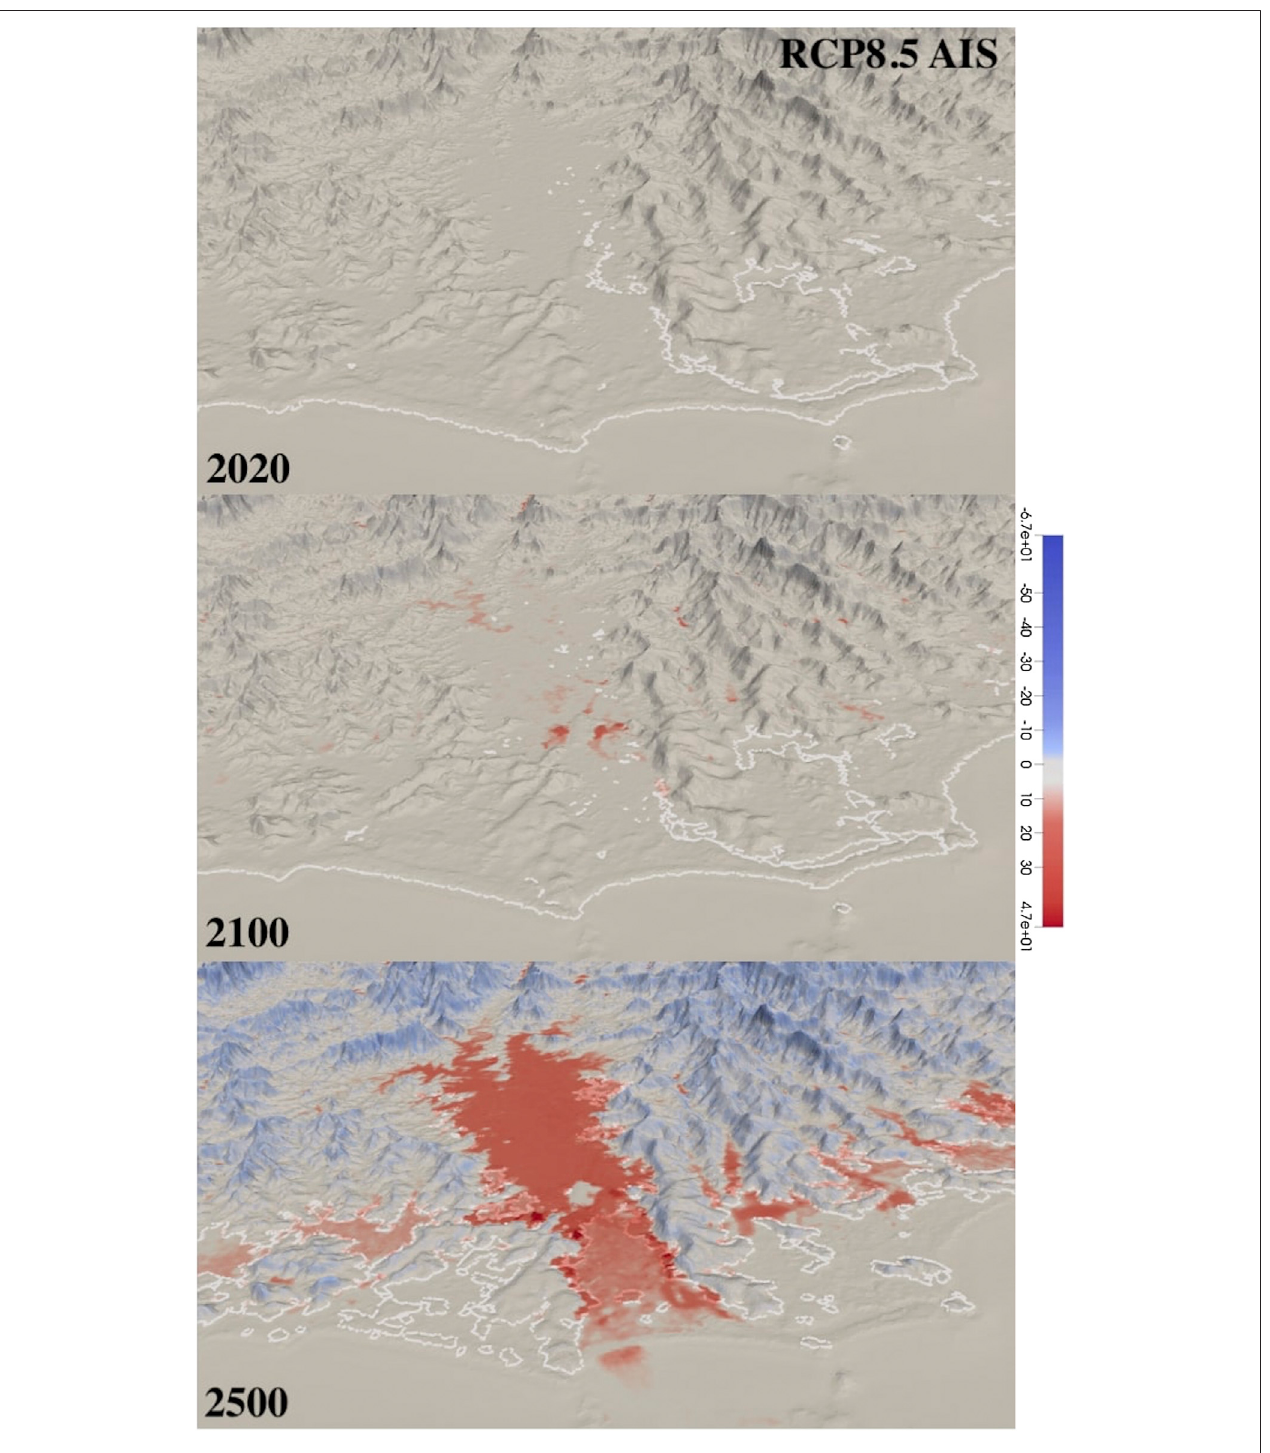
FIGURE 8 | Zoomed in regional visualization of the Tweed Valley fl oodplain region under Representative Concentration Pathways 8.5 Antarctic Ice Sheet, illustratingthedepositionofma fi csedimentsupplyintoerosiveenvironmentsandtheheavyaccumulationovertime,aswellasthetheimpactofsedimentsupplyonlocal dynamics. Red areas indicate deposition and blue areas indicate erosion (m 2 /a).